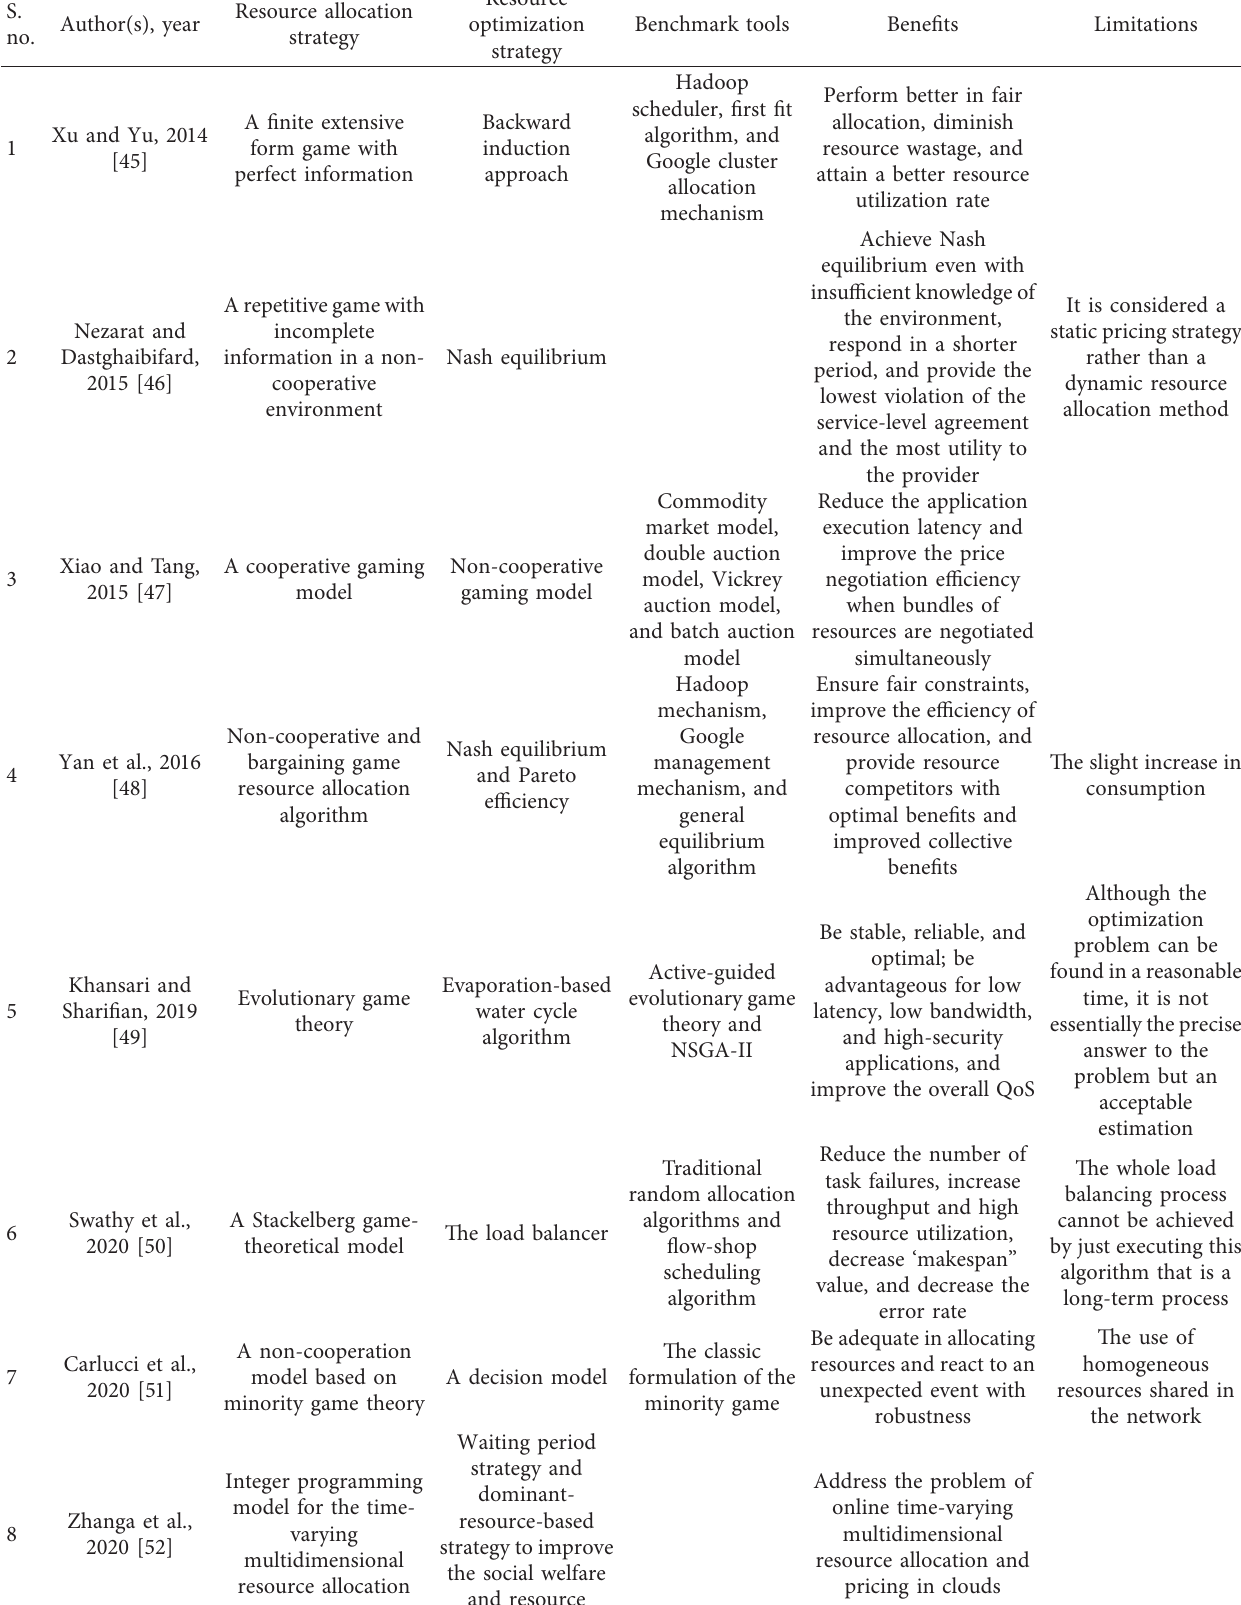
Table 3: A comparative analysis of game-theoretic models for resource allocation in cloud architecture [61–64].